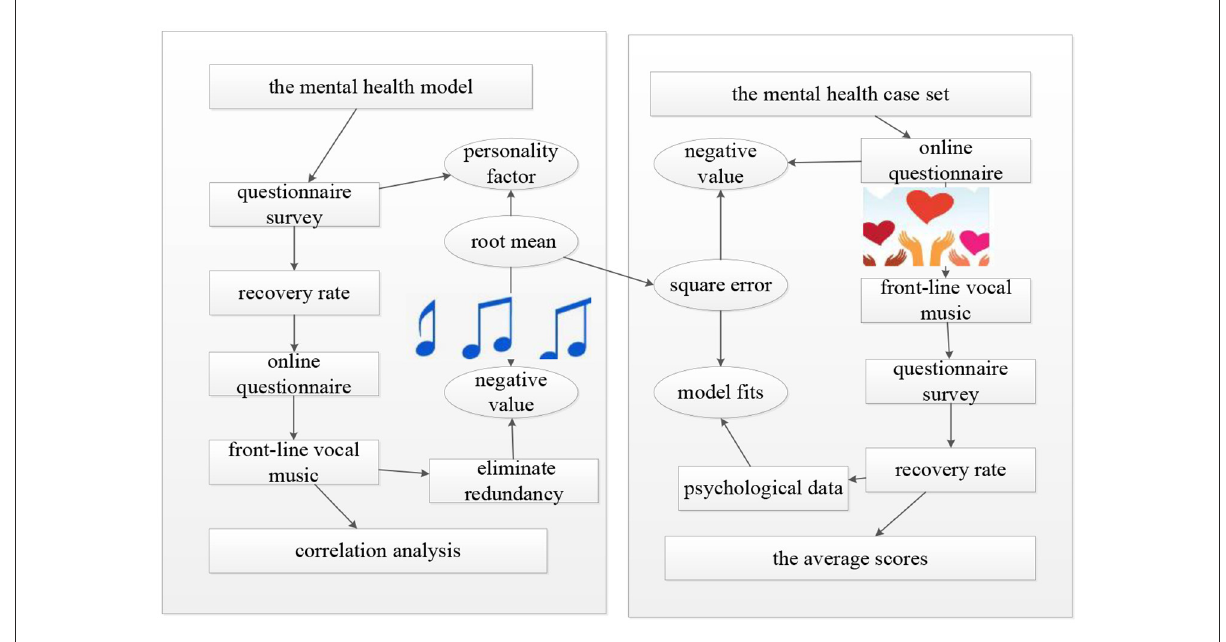
FIGURE5 The level of mental health in vocal music